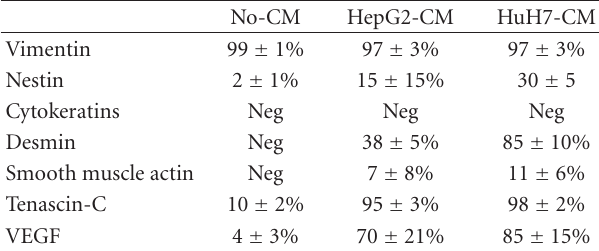
Table 3: Quantification of the changes in the expression of specific markers in L-MASCs cultured in the presence of non-CM, HepG2- CM and HuH7-CM. Data are expressed as mean ± standard deviation. Neg = no